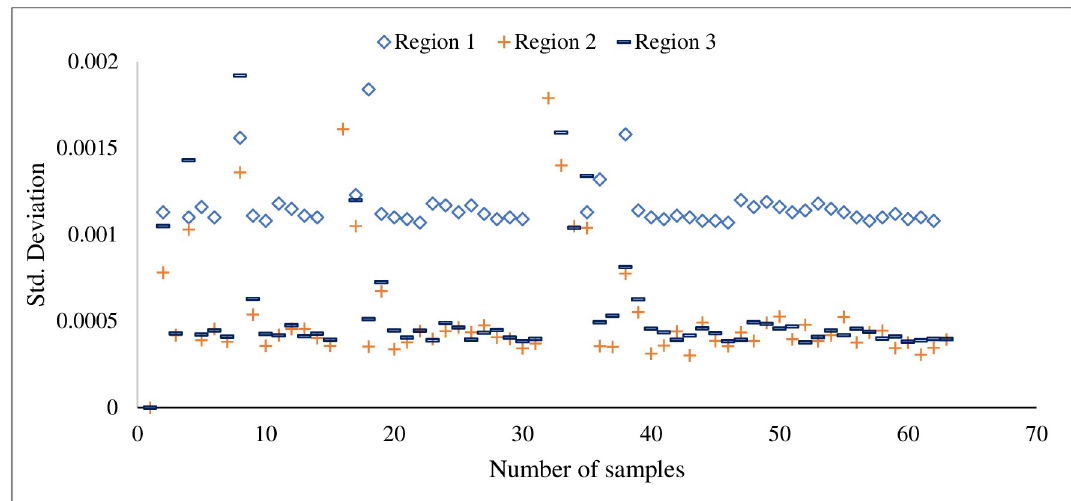
Fig 16. Standard deviation, statistical features for three stages of corrosion.